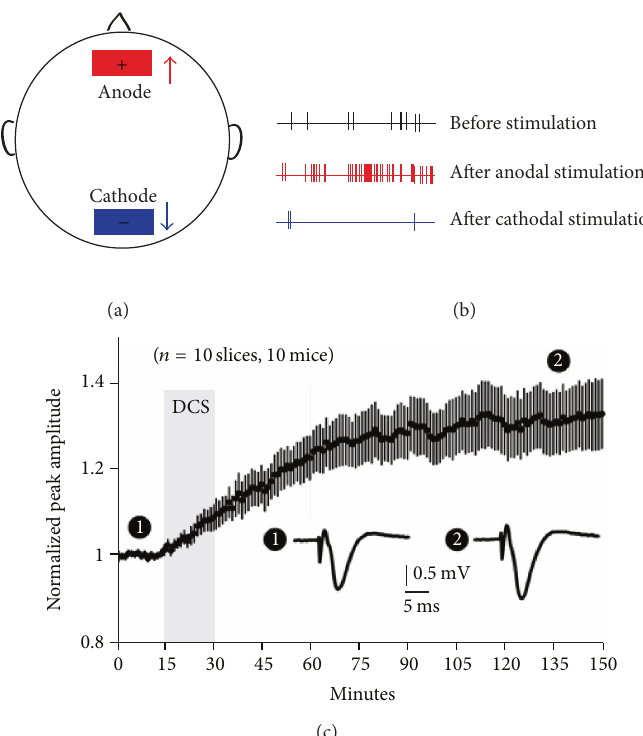
Figure 1: Physiological effects of tDCS. (a) Illustration of the typical placement of the anode (red square) and cathode (blue square) during stimulation of the primary motor cortex. The direction of stimulation causes differential effects on neuronal activation and plasticity. (b) Illustration of anodal (red) and cathodal (blue) transcranial direct current stimulation on spike activity in animals (modified from [39]). Anodal stimulation increased subsequent spike activity by lowering the membrane potential, whereas cathodal stimulation reduced subsequent spike activity in the stimulated area by increasing the membrane potential. (c) DCS promotes LTP in motor cortical slices. The sample of fEPSPs showing a 2-hour time course after DCS (vertical gray line) (from